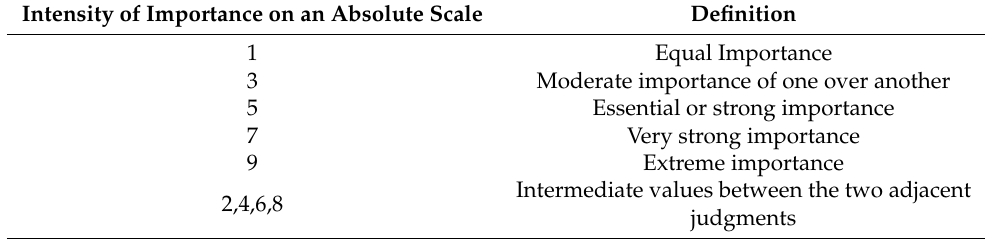
Table 4. Scale of Relative Importance [30].